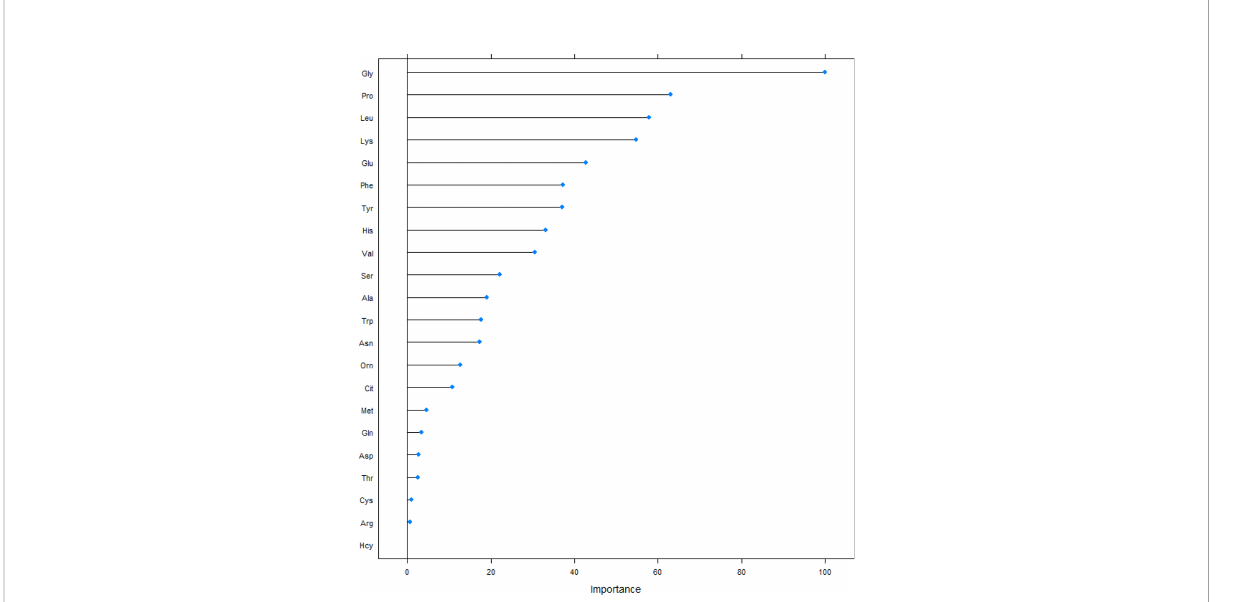
FIGURE 2 Sorting plot of amino acids of the magnitude of the effect of partial least-square method on the risk of DR. Ala, alanine; Asn, asparagine; Leu, leucine; Phe, phenylalanine; Trp, tryptophan; Tyr, tyrosine; Val, valine; Arg, arginine; Gly, glycine; Pro, proline; Thr, threonine; Cit, citrulline; Gln,